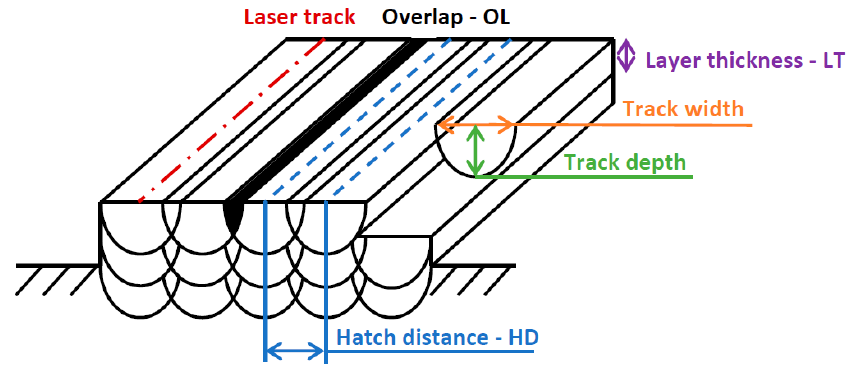
Figure 6. Parameters of tracks in cube sample [20].